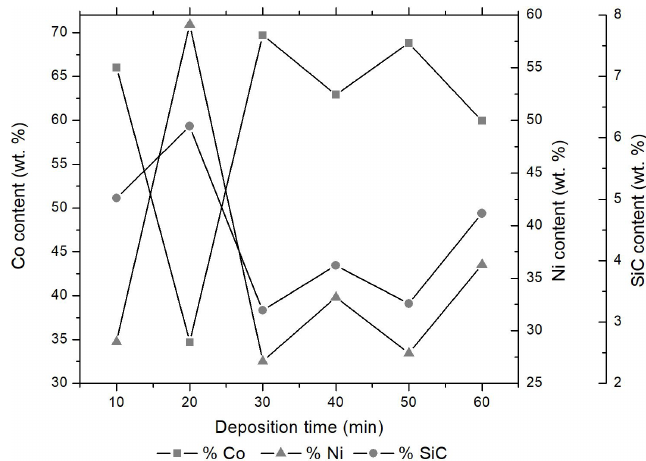
Figure 2. Percentage variation of the chemical composition of Ni-Co/SiC nanocomposites obtained at 5.5 A dm -2 as a function of deposition time.